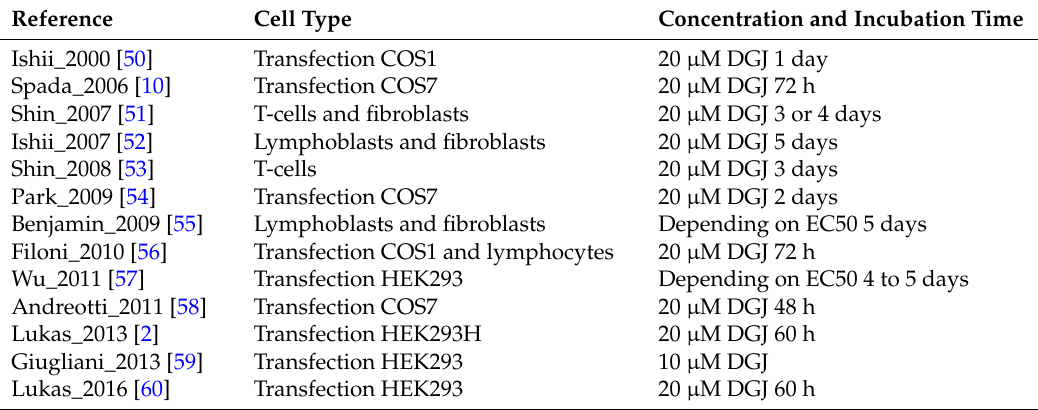
Table 1. Experimental conditions under which DGJ responsiveness has been assessed.